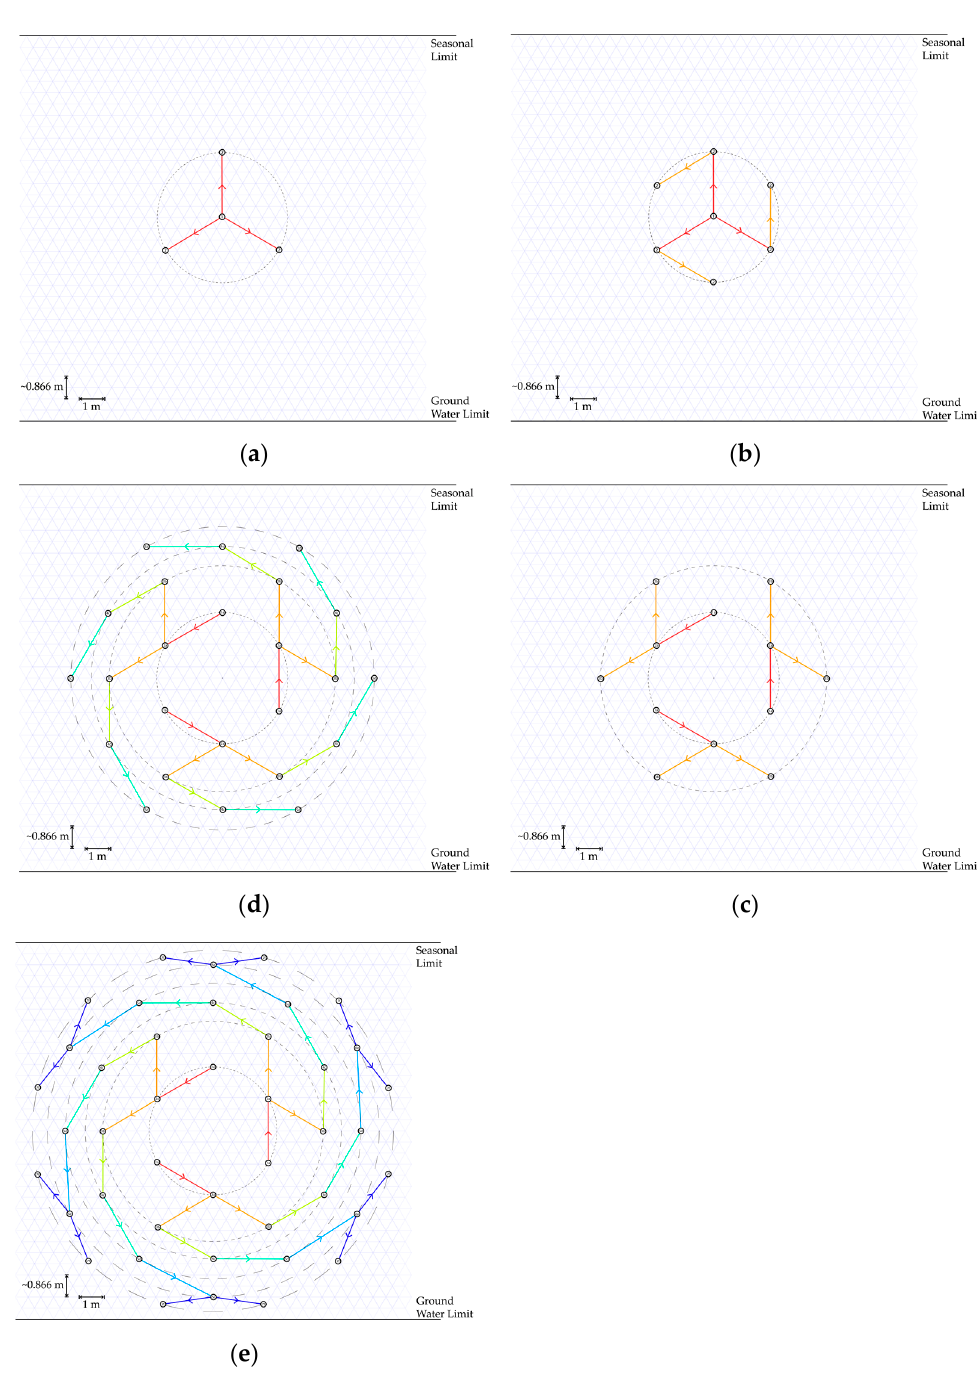
Figure 10. Vector analysis of temperature sensor location to heated borehole. Heating (charging), drifting (no flow), and cooling (discharging) phases were executed during the experimental period. Part of the experimental period was used to validate the model for a period of 78 days between 10 May and 26 July. The validated model was later expanded to 5 larger configurations of thermally active boreholes (4, 7, 12, 24, and 42) with two additional loading temperatures (40 ◦ C, 50 ◦ C) and an optimized flow rate. Figure 11 shows the layout of the 5 configurations.